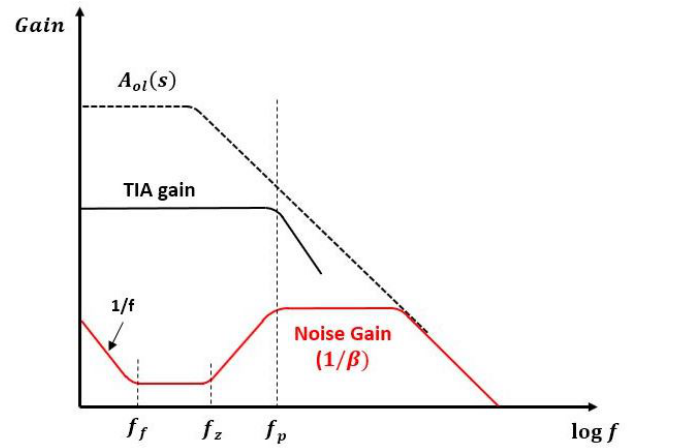
Figure 4. The frequency response of TIA and